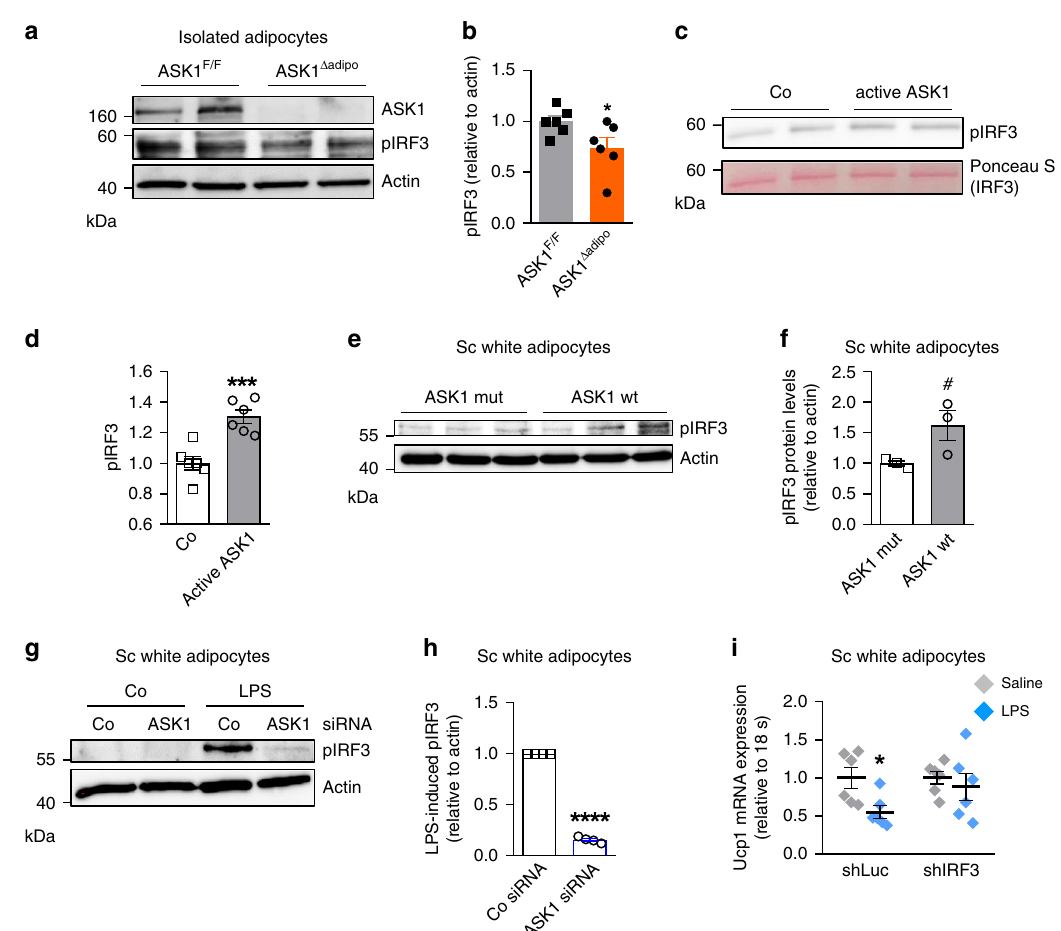
Fig. 6 ASK1 phosphorylates IRF3. a , b Representative western blot and quanti fi cation of pIRF3 protein levels in isolated adipocytes of HFD-fed ASK1 F/F and ASK1 Δ adipo mice. n = 6 mice per group. * p = 0.048. c , d Representative western blot and quanti fi cation of pIRF3 upon incubation of recombinant IRF3 with or without active ASK1. n = 6 biological replicates. *** p = 0.0006. e , f Western blot and quanti fi cation of pIRF3 protein levels in subcutaneous